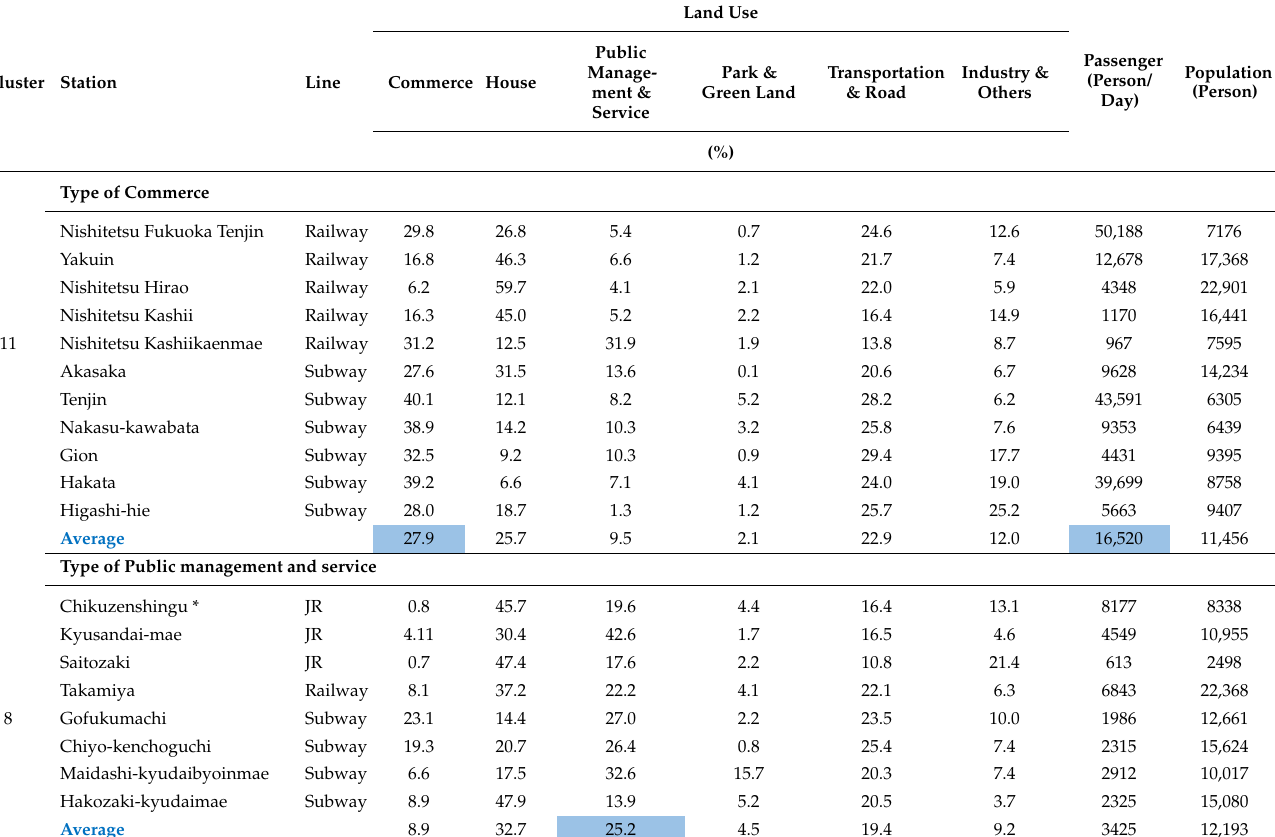
Table 10. Result of cluster analysis in 0–400 m radius (including land use, population, and